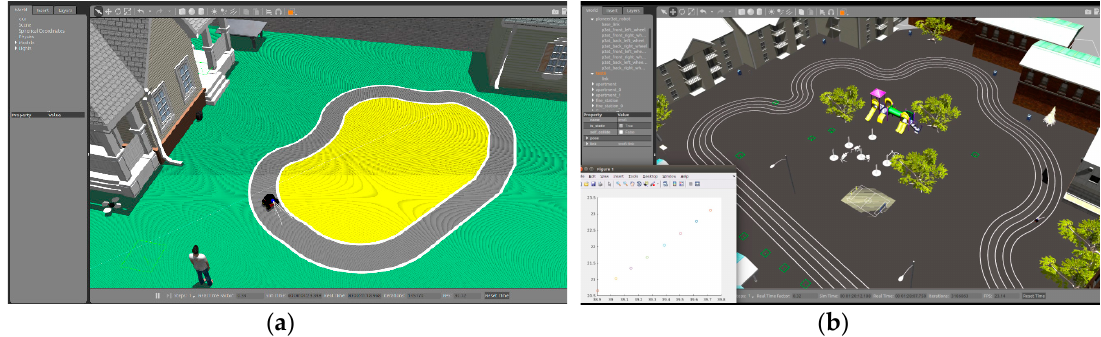
Figure 12. Gazebo real-time physic engine simulation of the environments; ( a ) Normal Track Environment, ( b ) Athletic field Track.